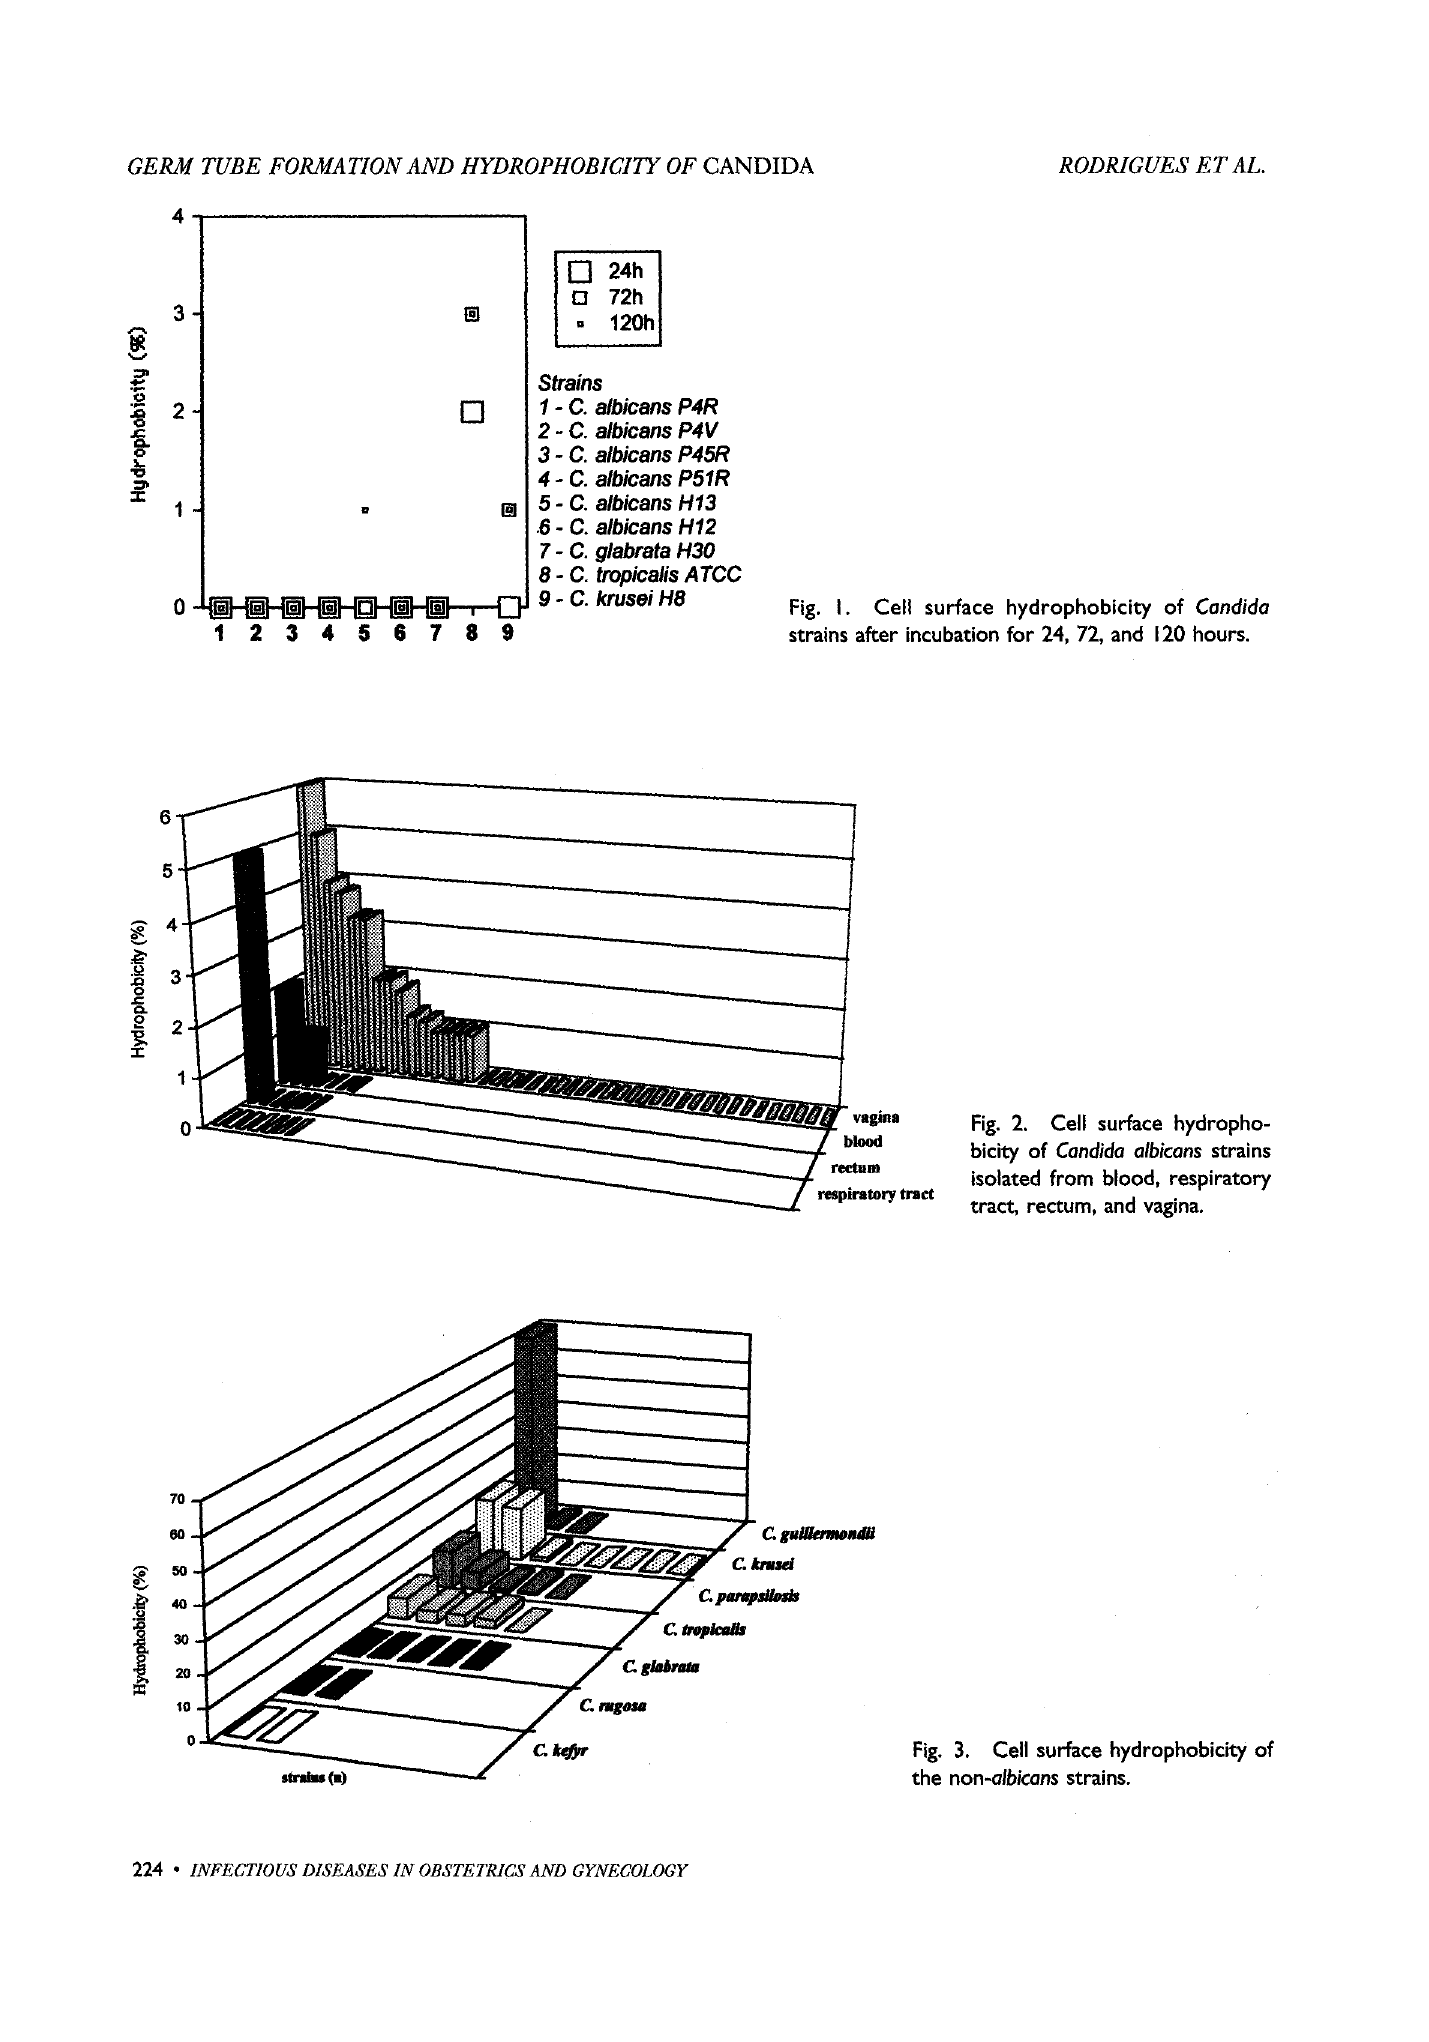
Fig. 3. Cell surface hydrophobicity of the non-albicans